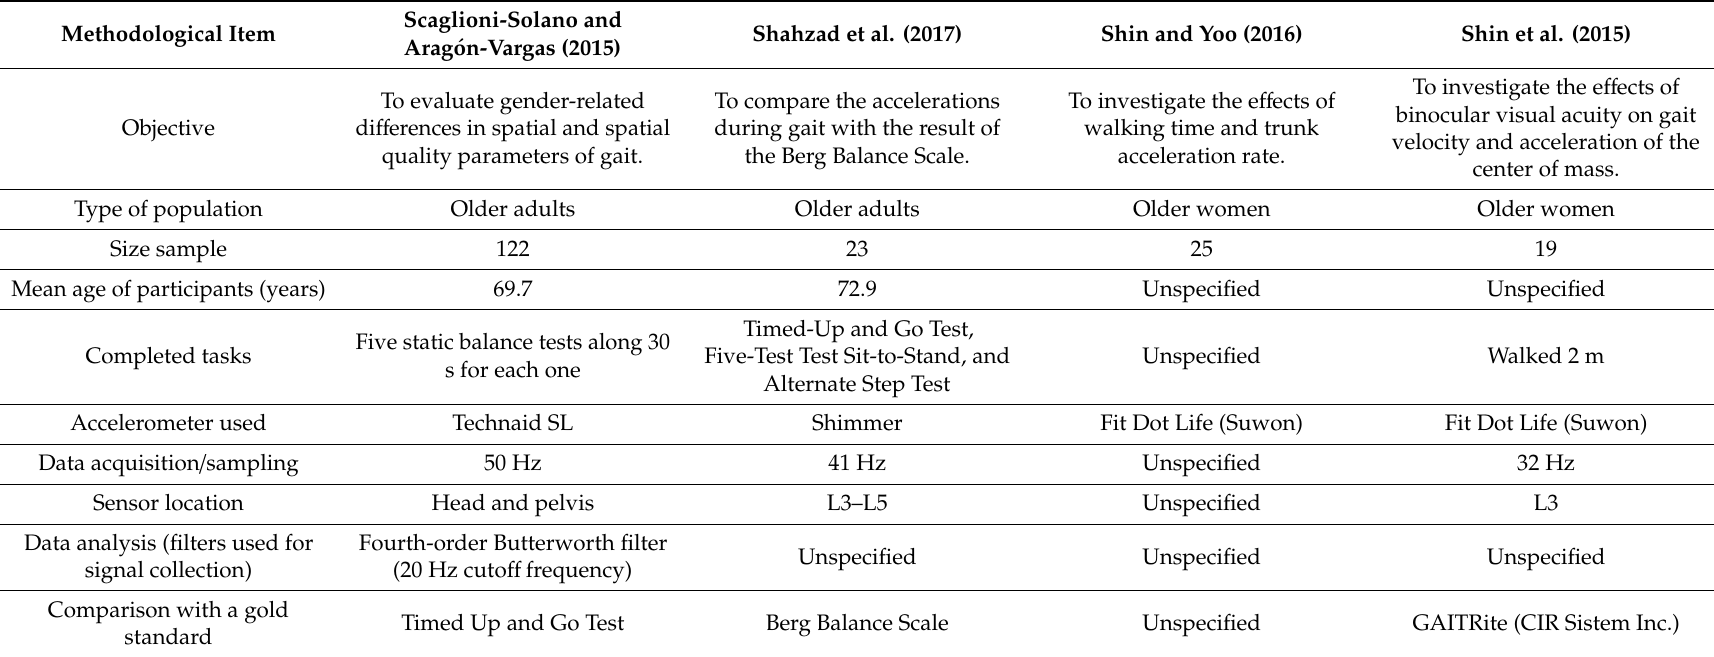
Table A6. Methodological details of the research